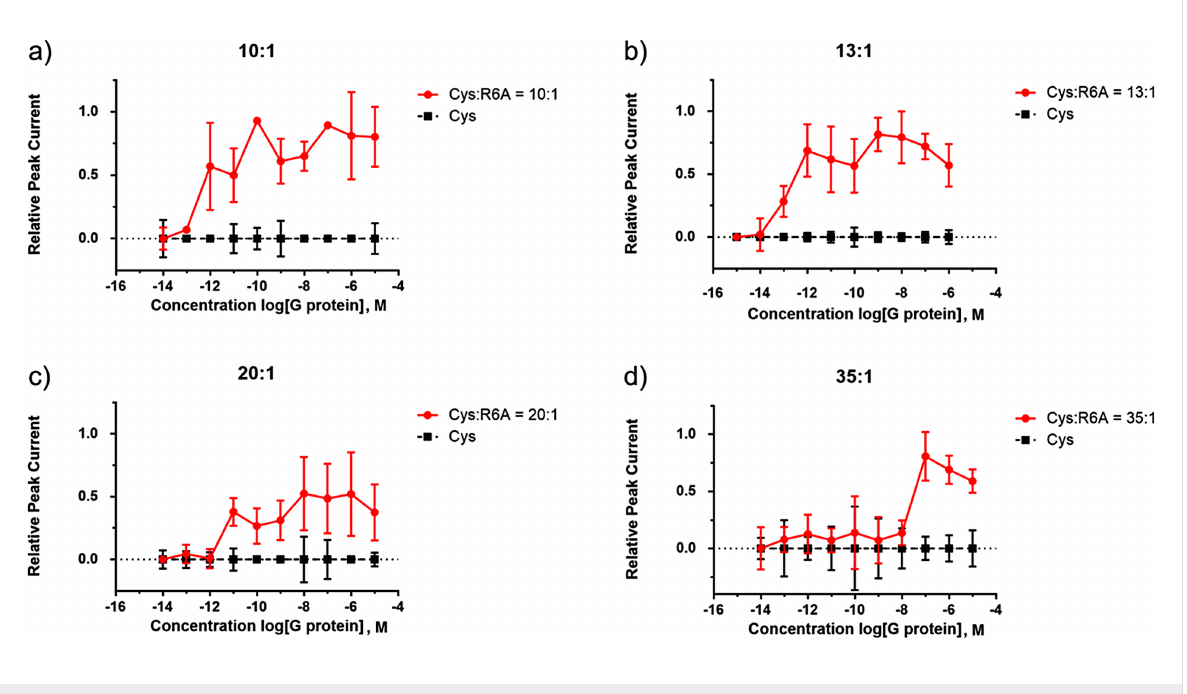
Figure 11: Calibrating the array-based signaling experiment for monitoring small molecule G-protein interactions.